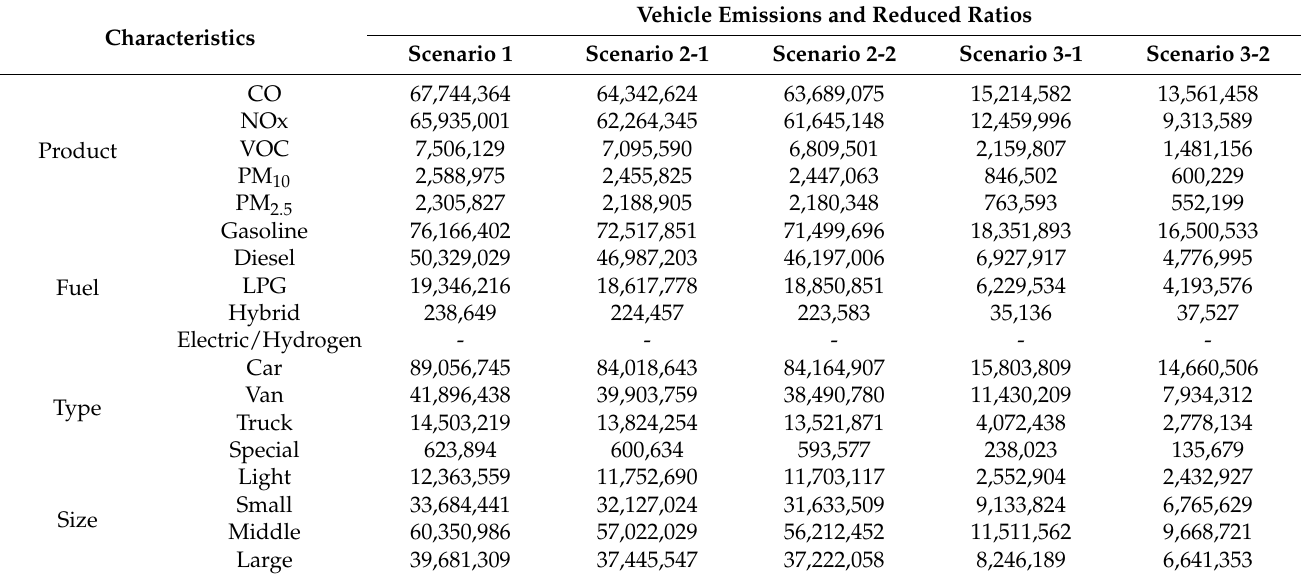
Table 6. Summary of results on vehicle emissions and reduction efficiency by